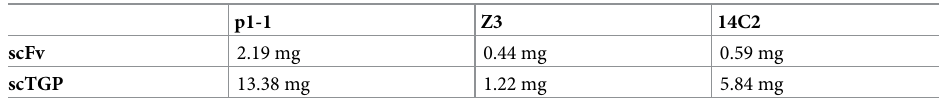
Table 1. Comparison of protein purified from 1lit culture in scFv and scTGP